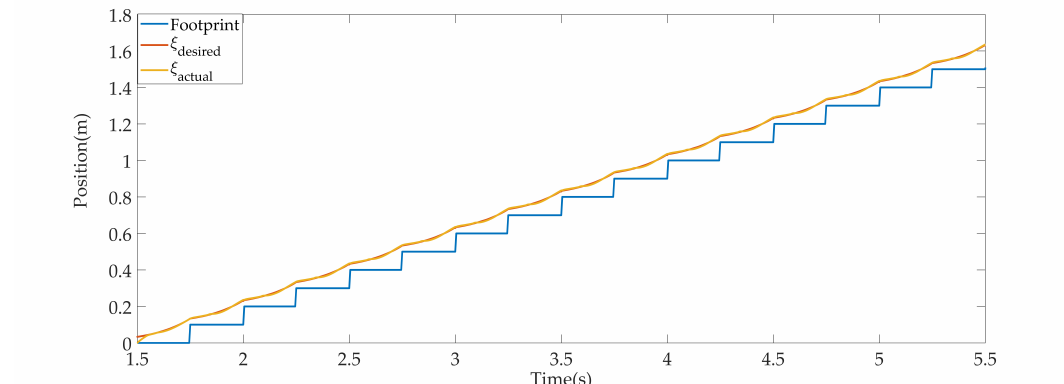
Figure 6. Comparison of the desired Footprint from a high planner, the desired and the actual Capture Point trajectory.